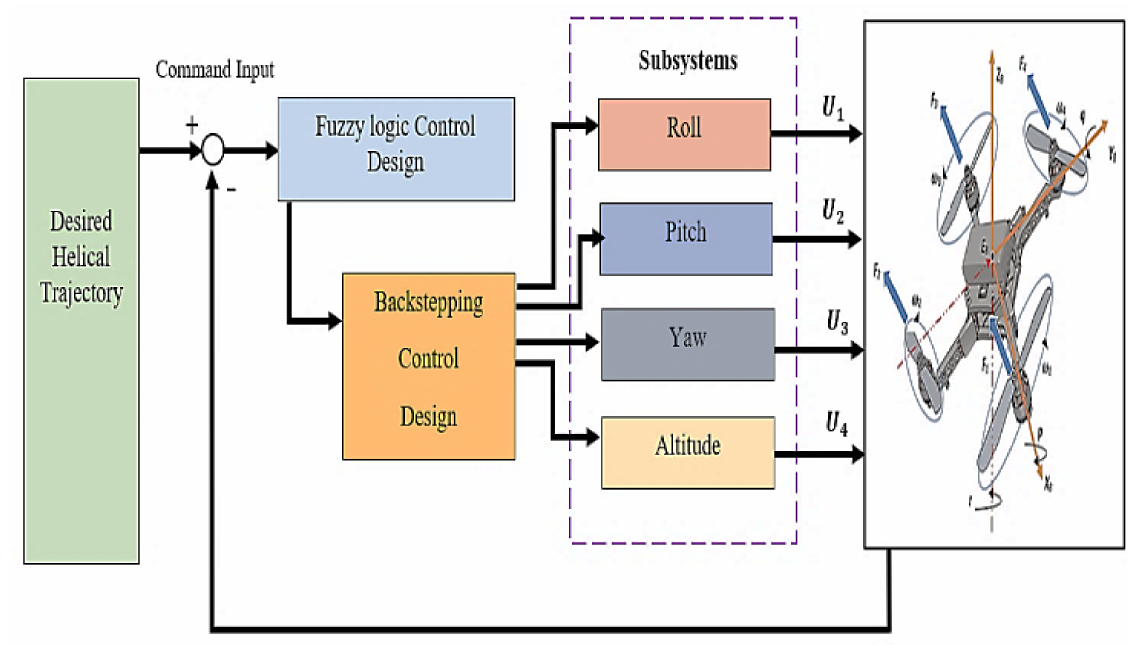
Figure 3. Proposed Fuzzy based Backstepping Control